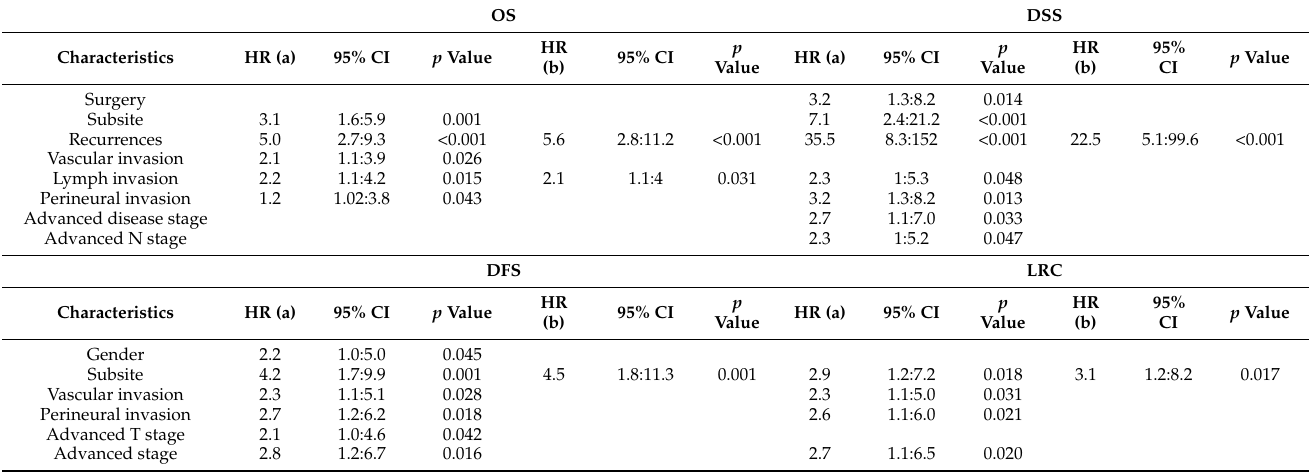
Table 4. Results from univariate and multivariate analyses. OS